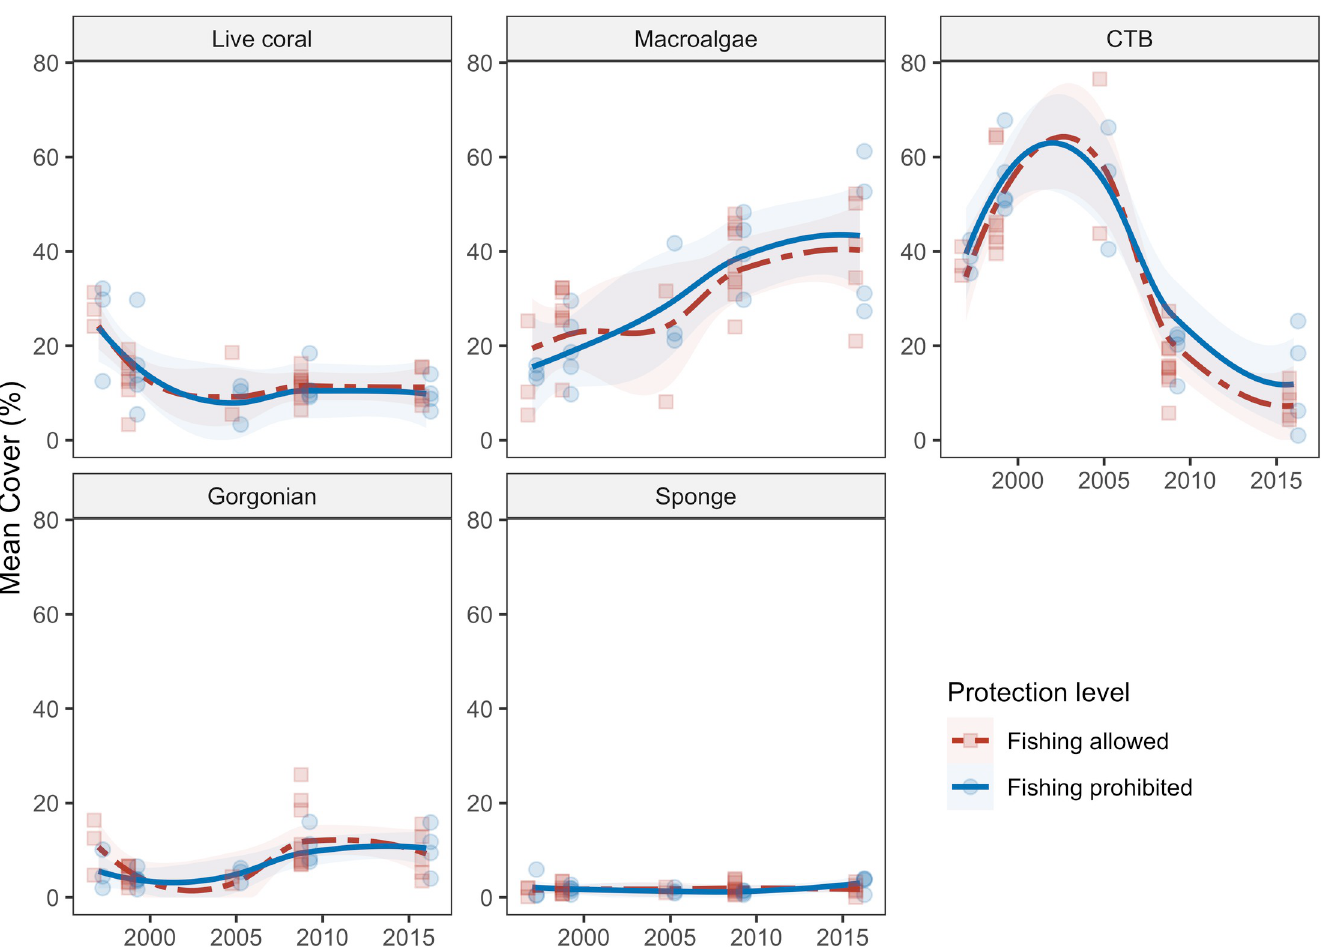
Fig 2. Percent cover of five benthic categories over time grouped by protection status. Points are site means, lines are loess-smoothed curves with a span of 1, and shading indicates the 95% confidence intervals of the loess fits.